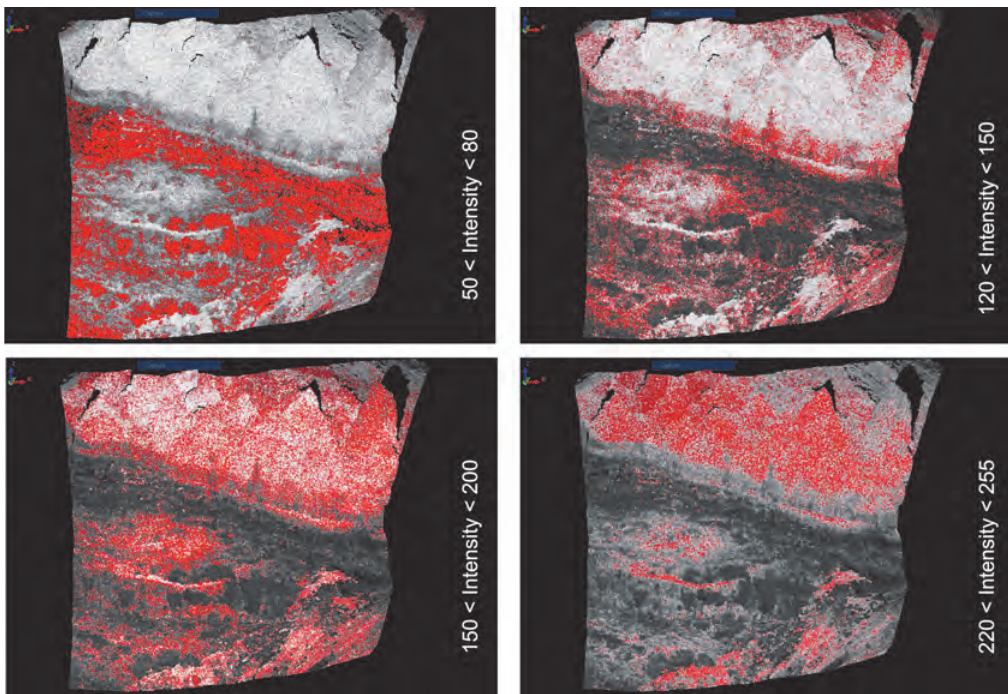
Fig. 12. Selection of the points of the B-zone on the basis of the intensity ranges. Four ranges are considered: [50- 80], [120-150], [150-200] and [220,